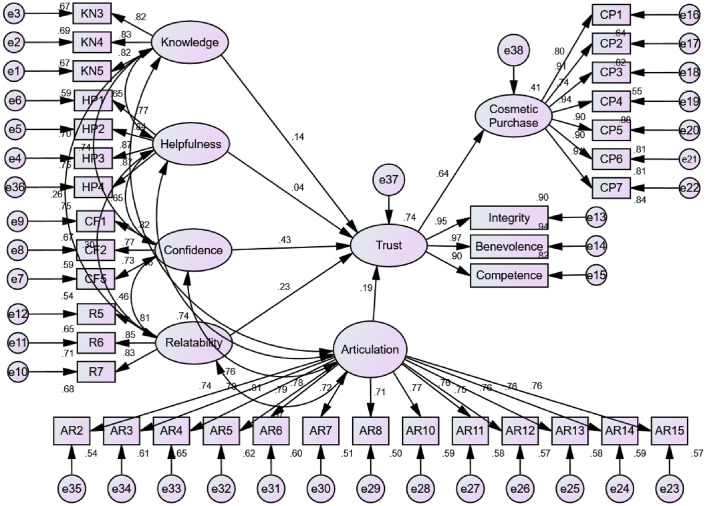
Measurement model.